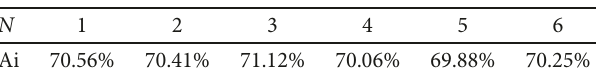
Figure 7: Laboratory experimental setup of the WMS-based CO sensor. Table 1: Results of the detection repeatability test under 70%